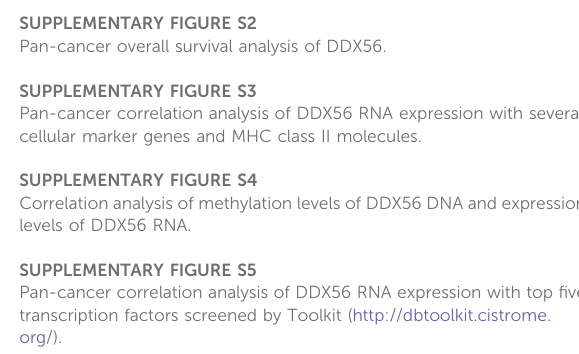
Tumors involved in each analysis.